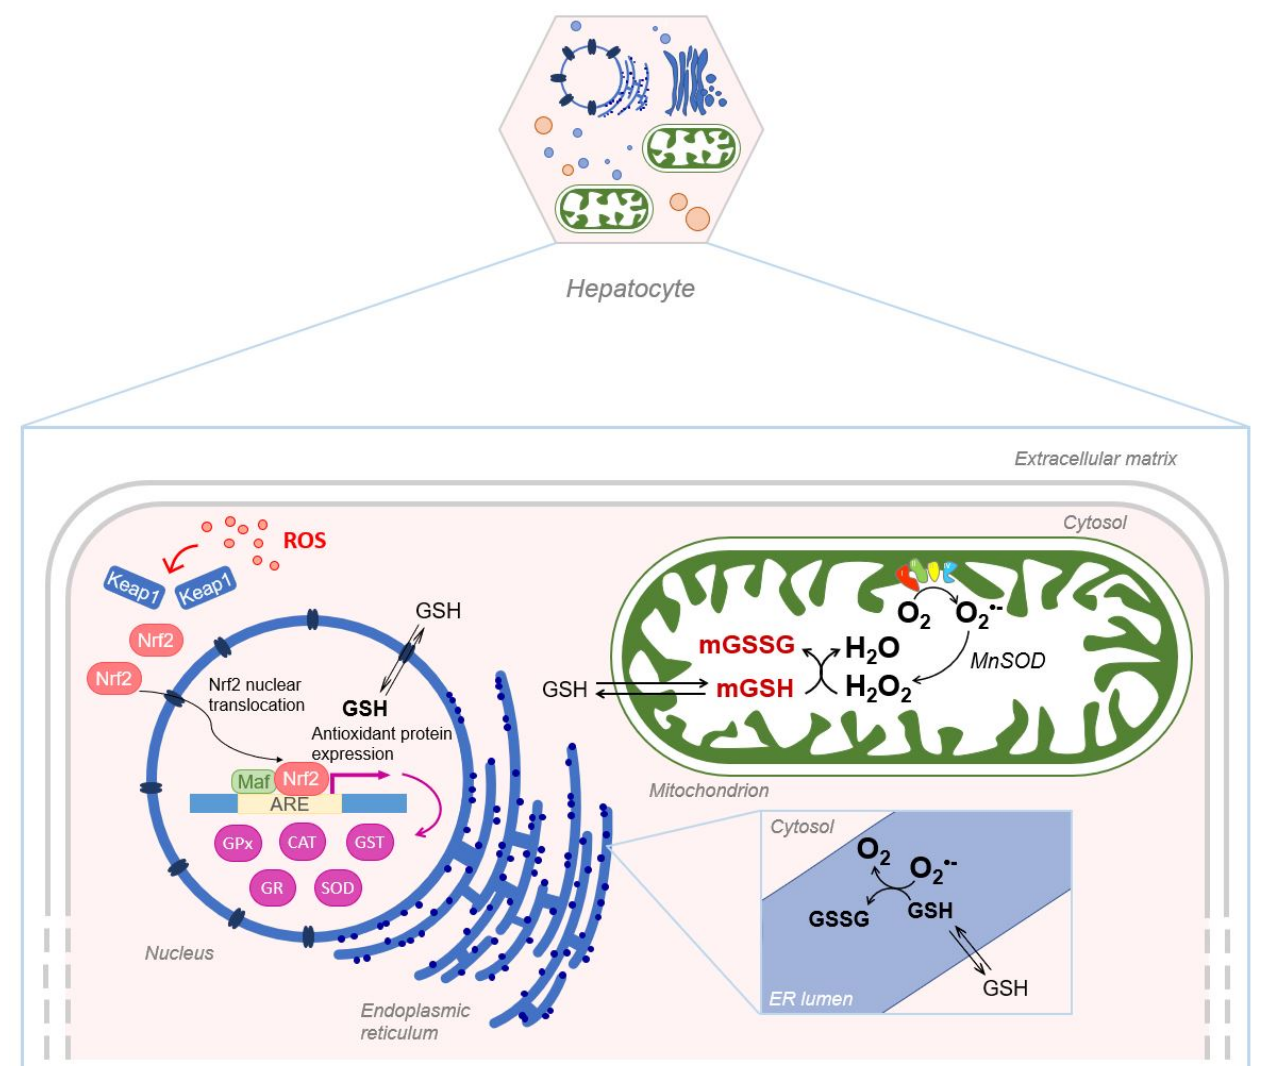
Figure 5. Schematic representation of GSH compartmentalization, in the nucleus, mitochondria and endoplasmic reticulum. mGSH: mitochondrial GSH; mGSSG: mitochondrial